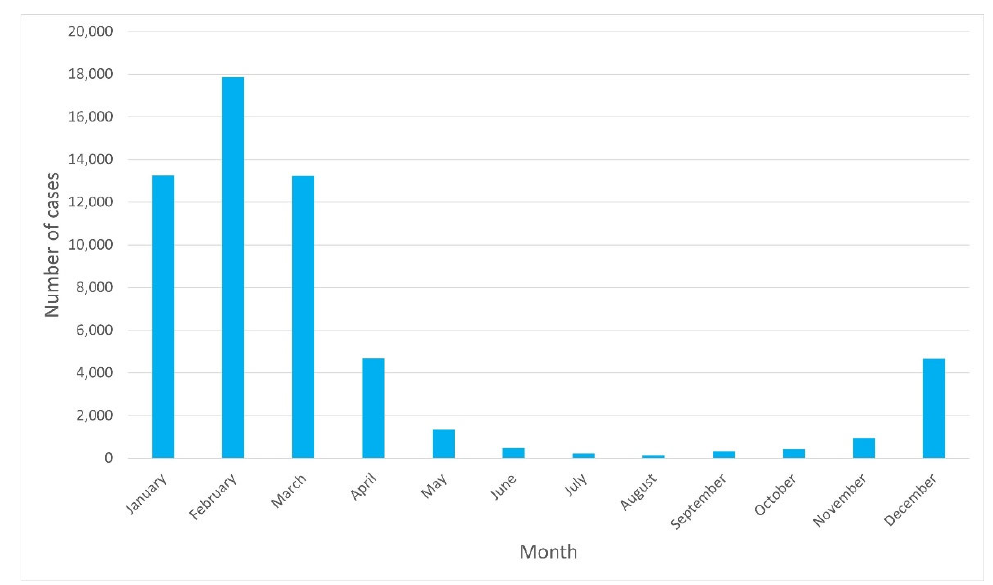
Figure 2 . Number of RSV hospitalization cases per month.